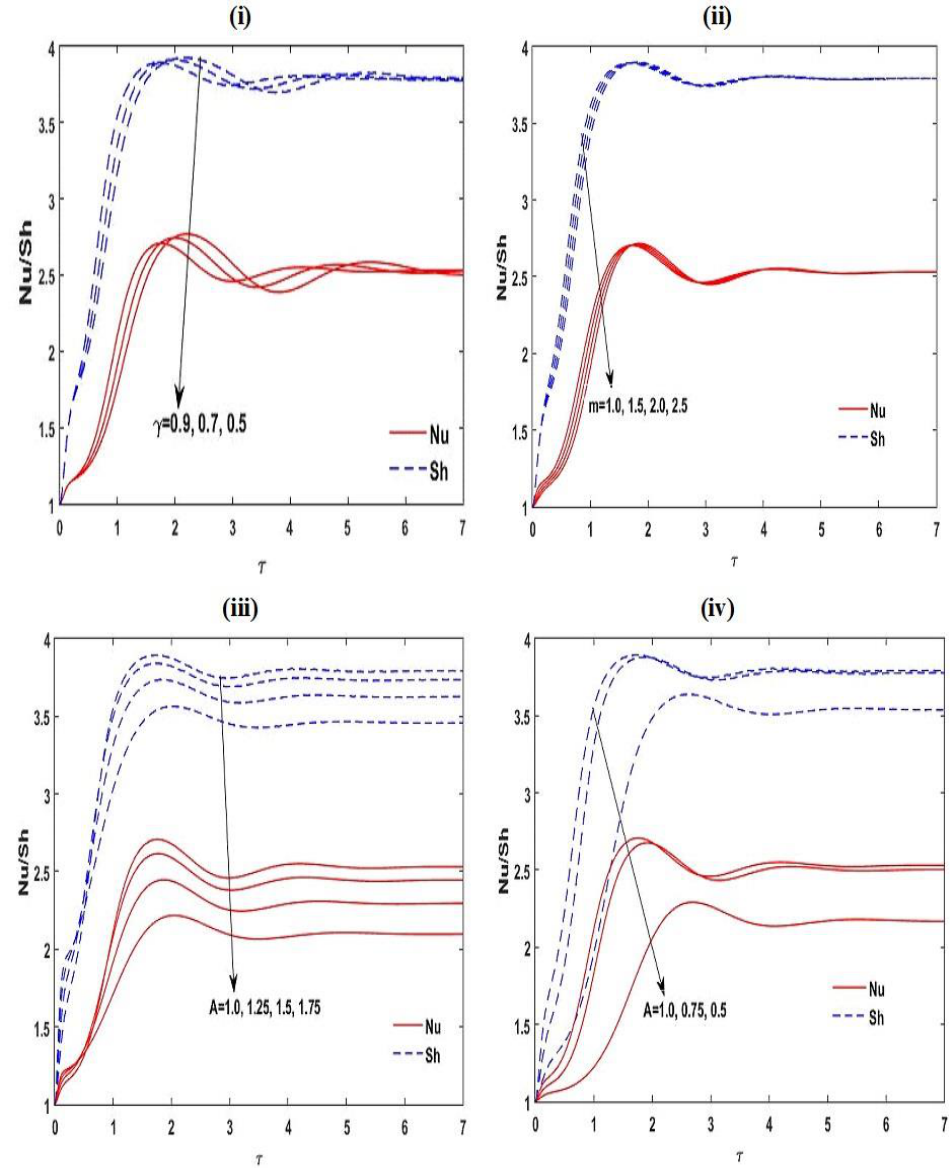
Figure 11. Disparity of the unsteady Nu and Sh with (cid:101) τ for different values of γ , m , and A at Le = 2, m = 1.5, A = 1, R DS = 3, S N = 0.5, γ = 0.5, K RN = 0.5, and Va =